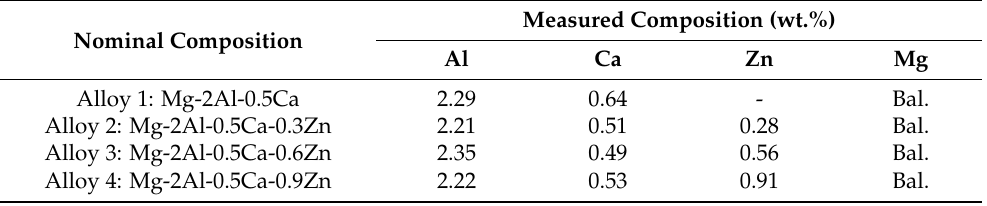
Table 1. The nominal compositions of the experimental alloys. Measured Composition (wt.%) Nominal Composition Al Ca Zn